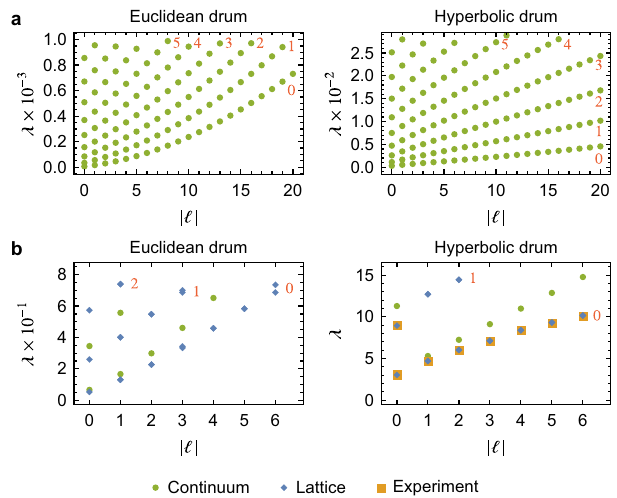
Fig. 2 | Angular momentum dispersion. a Rescaled frequency λ n ‘ g vs. angular momentum ℓ foreigenmodes u n ‘ g of the continuum Laplace-Beltramioperator, i.e., solutionstoEq.(2),fortheEuclidean(left)andhyperbolic(right)geometry.Forthe fi rst six branches, the value of n is indicated by red numbers. b Same data for a Euclidean{3,6}(left)andhyperbolic{3,7}(right)tessellation,eachwith85sites.For the hyperbolic lattice, we additionally show the experimental results (orange squares) obtained from the electric circuit.